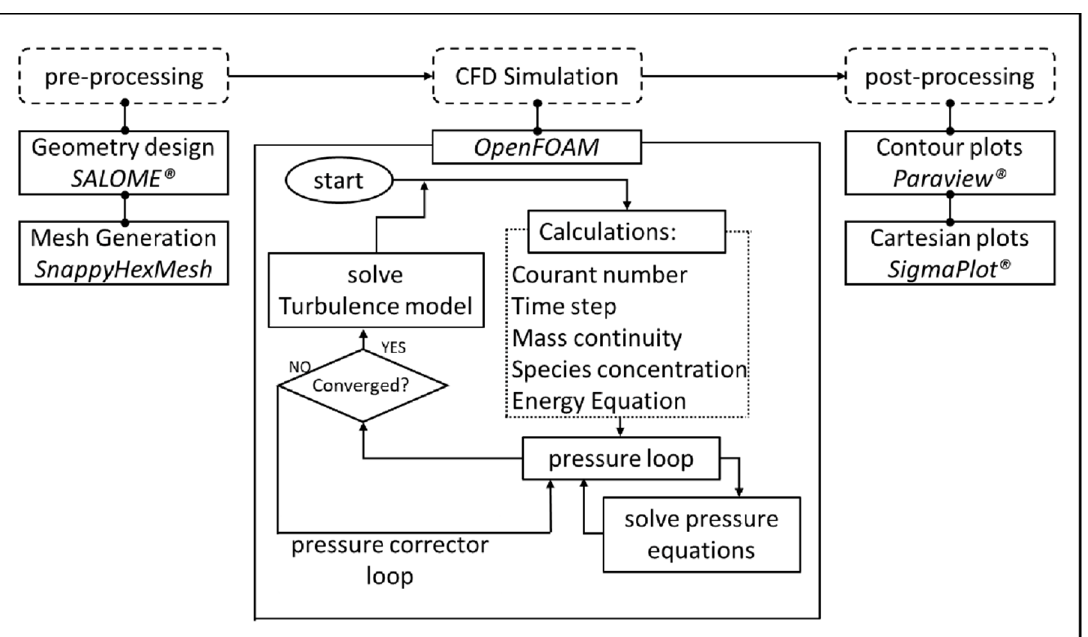
Table 4. Computational boundary conditions.